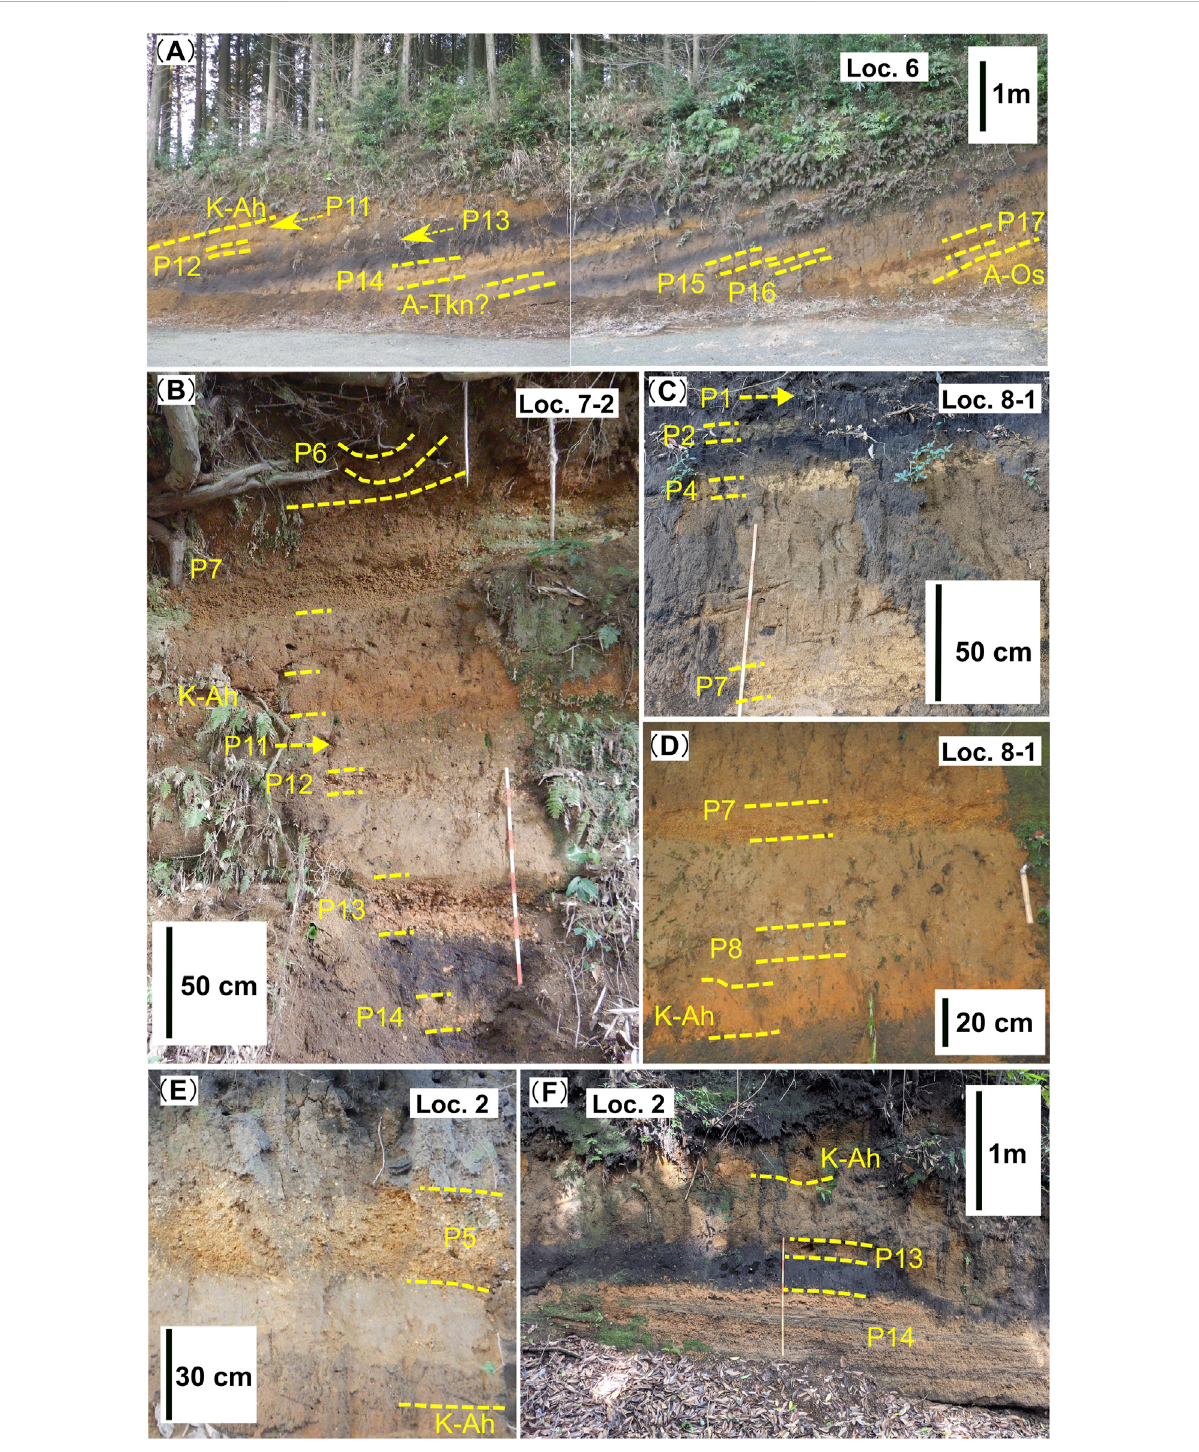
FIGURE 4 (A) StratigraphicrelationshipoftephradepositsduringStage1andStage2atLoc.6,19.8 kmeastoftheKitadakesummitcrater.Inthisoutcrop,a stratigraphical relationship between the P17-P11 tephra deposits is observed with some exotic tephras. (B) Stratigraphic relationship of tephra deposits duringStage 2 atLoc.7 – 2,16.2 kmsoutheastoftheKitadakesummit crater. (C,D) Stratigraphic relationshipoftephradeposits duringStage 2 and Stage 3. At Loc. 8 – 1, 12.5 km southeast of the Kitadake summit crater. (E,F) Stratigraphic relationship of tephra deposits during Stage 2 at Loc. 2, 9.2 km northwest of the Kitadake summit